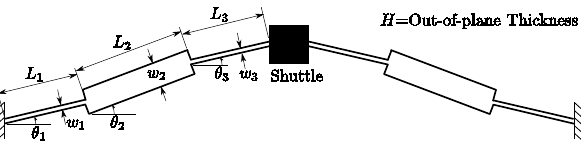
Figure 6. Parameters of bistable mechanism. It should be noted that three bistable mechanisms of this kind are employed in the statically-balanced mechanism shown in Fig. 5, i.e., Part A, Part B and the balancing bistable mechanism. Table 1. Design values of the tristable mechanism (consisting of two bistable mechanisms connected in series, i.e., Part A and Part B) and the balancing bistable mechanism (see Fig. 6 for the parame- ters). Part A of Part B of Balancing Parameter Tristable